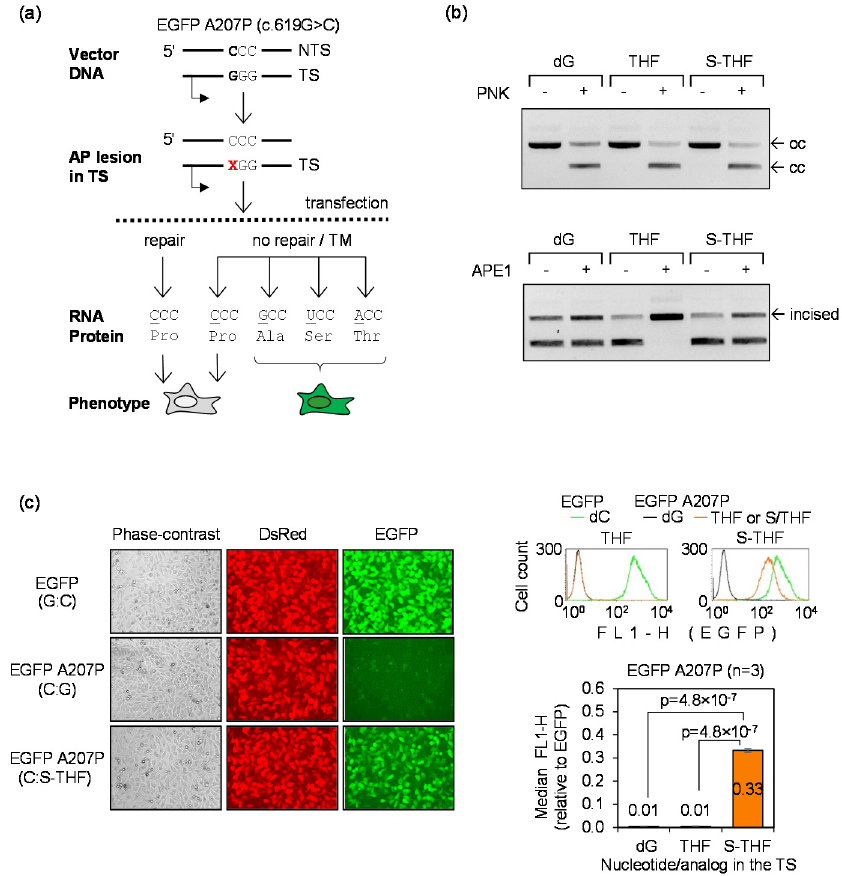
Figure 4. Detection of TM by AP lesion in the EGFP A207P (c.619G>C) reporter: ( a ) Scheme of the EGFP A207P reporter indicating position of the lesion (X) at the nucleotide 619 of the TS and possible outcomes of the transcriptional bypass; ( b ) Verification of incorporation of the lesions into the vector DNA. Upper gel: proof of incorporation of synthetic DNA strands containing dG or the indicated AP lesions (THF, S-THF) into the TS. The vector containing the single-stranded 18-nt gap in the TS migrates as open circular form (oc). E ffi cient ligation of synthetic oligonucleotides into the gap is confirmed by reconstitution of the covalently closed circular form (cc). Lower gel: verification of incision of the THF lesion by human APE1 and inhibited incision of the S-THF; ( c ) TM visualized by fluorescence microscopy and quantitative flow cytometry as a reversal of the non-fluorescent EGFP phenotype. HeLa cells were transfected with the indicated EGFP constructs in the presence of DsRed-Monomer as a transfection marker.